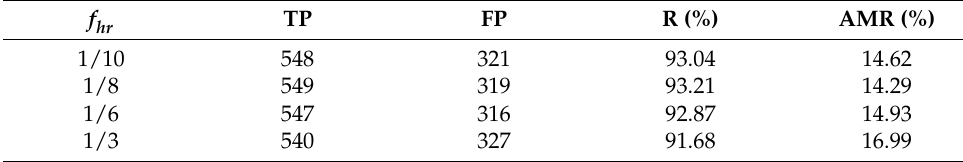
Table 5. Comparison of different f hr values in the integrated detector.